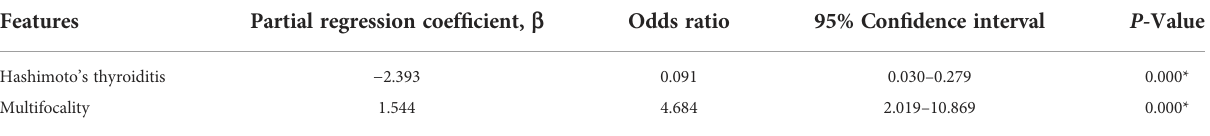
TABLE 3 Multivariate logistic regression analysis of clinical features related to the patients with PTC with malignant CCLNs.